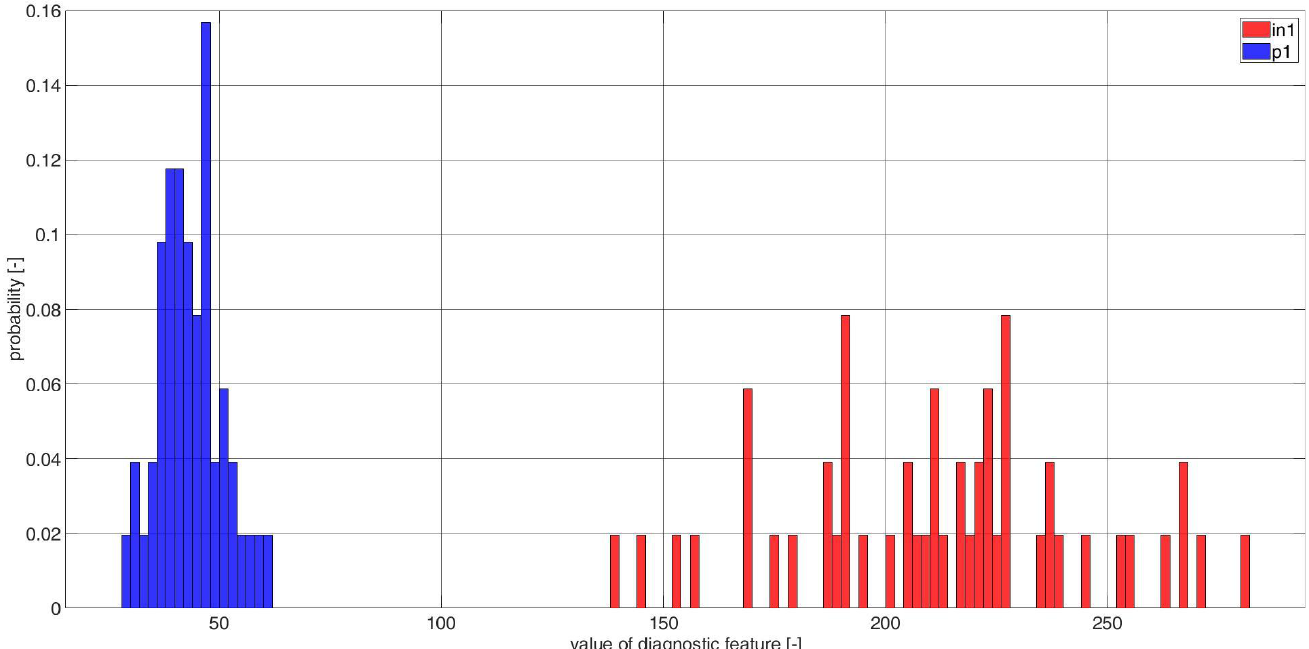
Figure A24. Histograms of diagnostic features based on the CCSM3 (correlation number is 24 — Table A1) bearings in2 and p2.